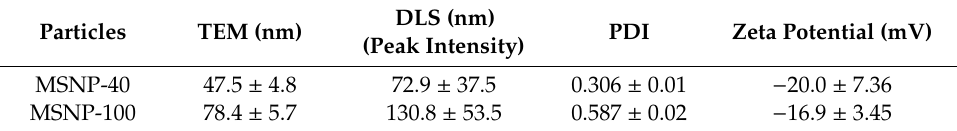
Table 1. Particle size and zeta potentials date for MSNP-40 and MSNP-100.